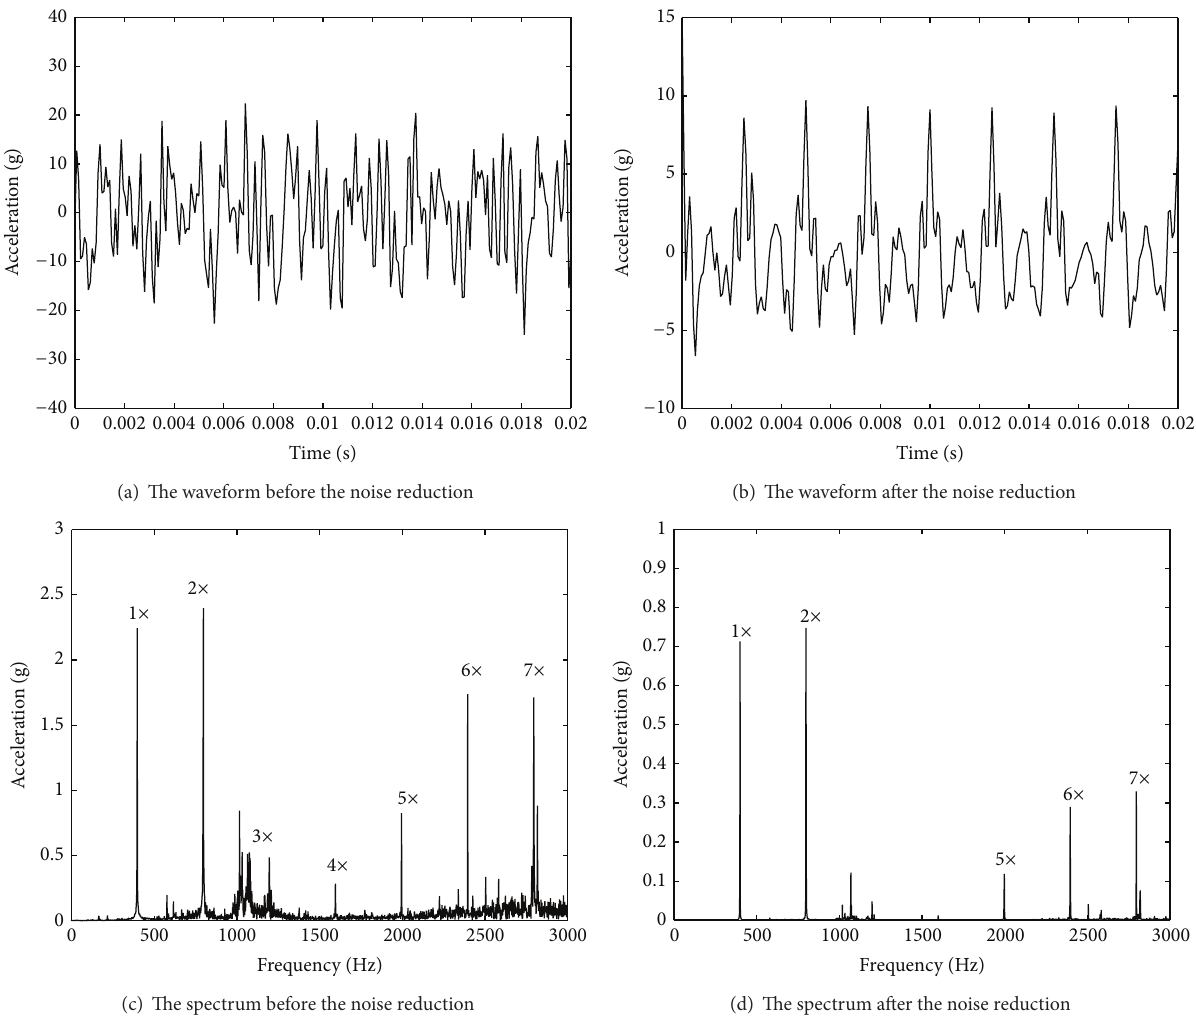
Figure 19: The time domain waveform and frequency spectrum before and after the noise reduction when rotating speed is 24000